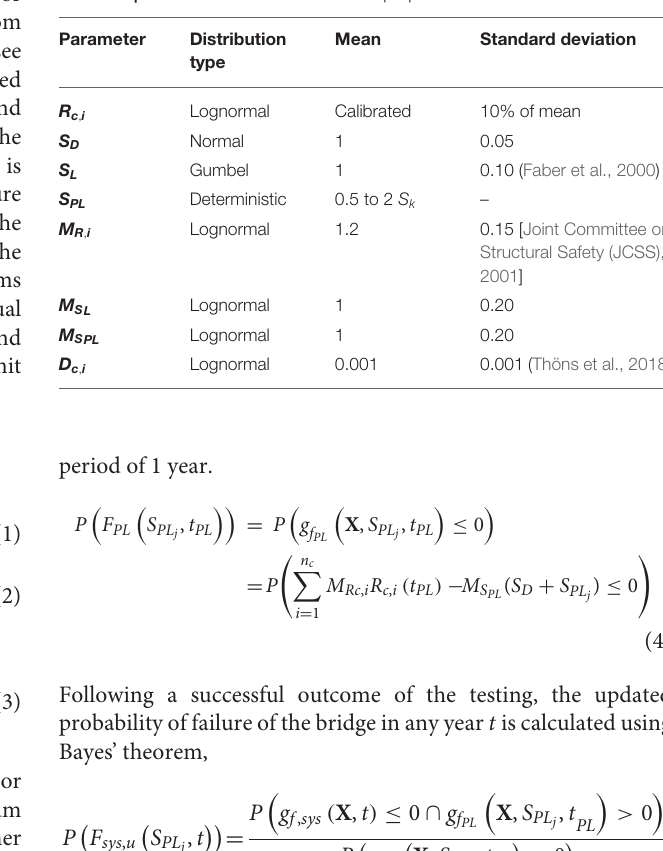
TABLE 2 | Probabilistic Model of structural